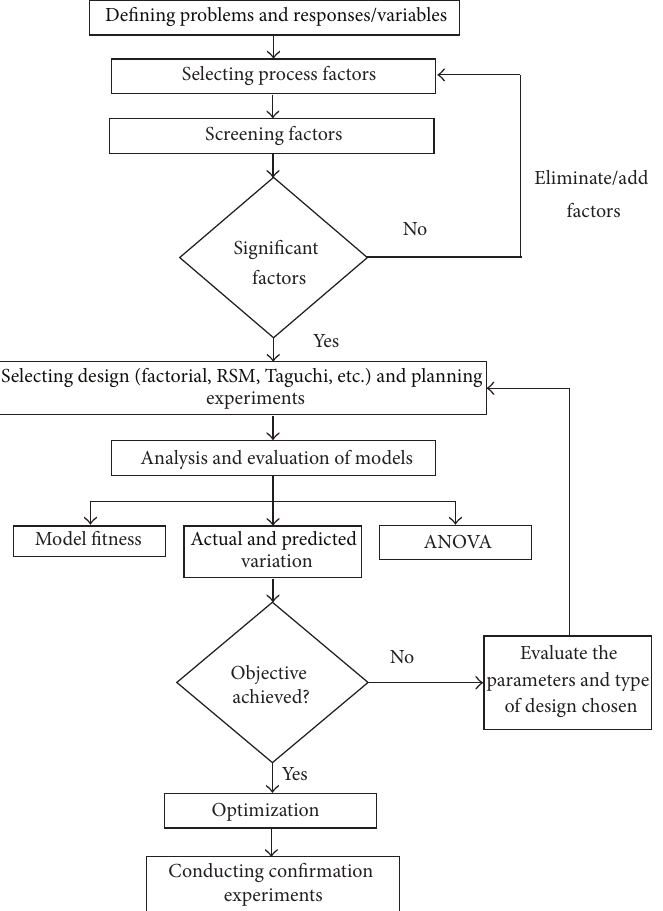
Figure 1: Flow chart for